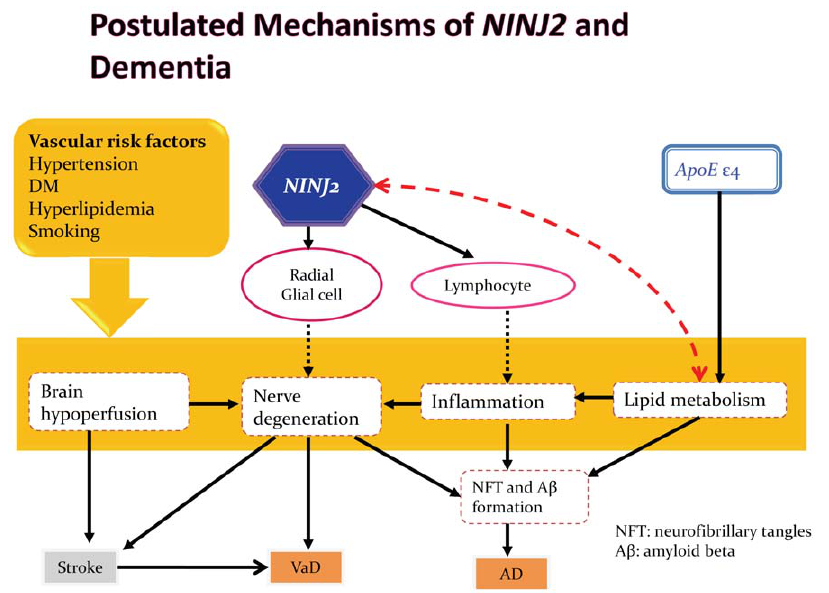
Figure 2. Postulated pathway of NINJ2 and mediators involved in the formation of dementia. Solid lines indicated pathways have been well documented; dotted lines indicated speculated pathway. NFT denotes neurofibrillar tangle. A b denotes beta amyloid.